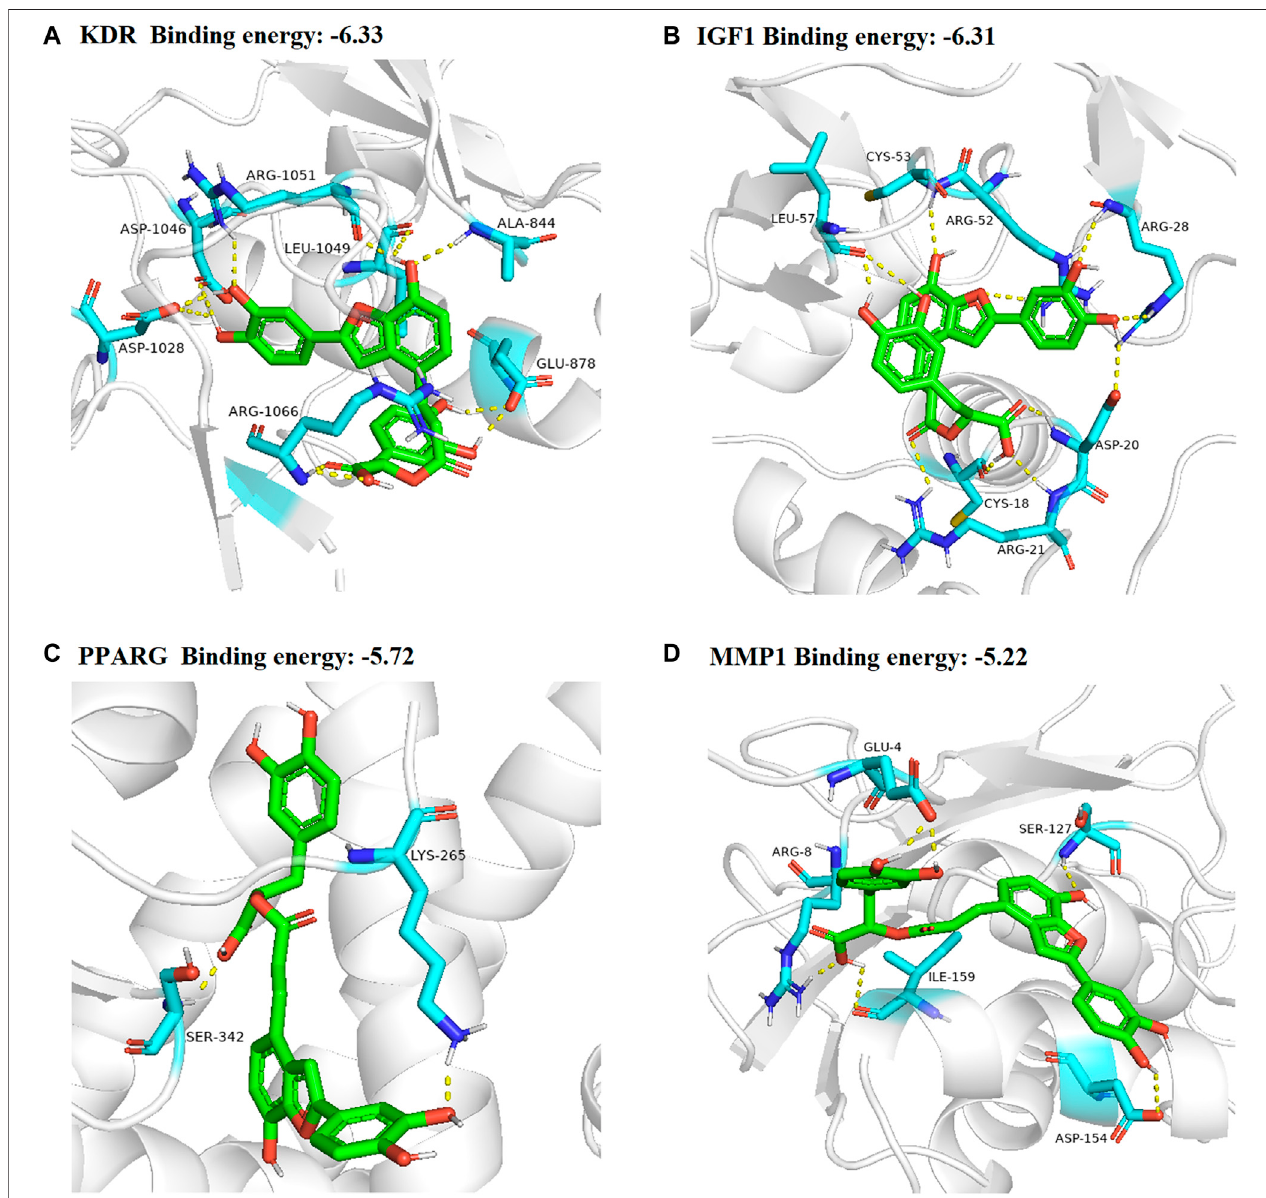
FIGURE 7 | 3D docking conformation of SAC with (A) KDR, (B) IGF1 (C) PPARG (D) MMP1, respectively. The green sticks represent SAC.